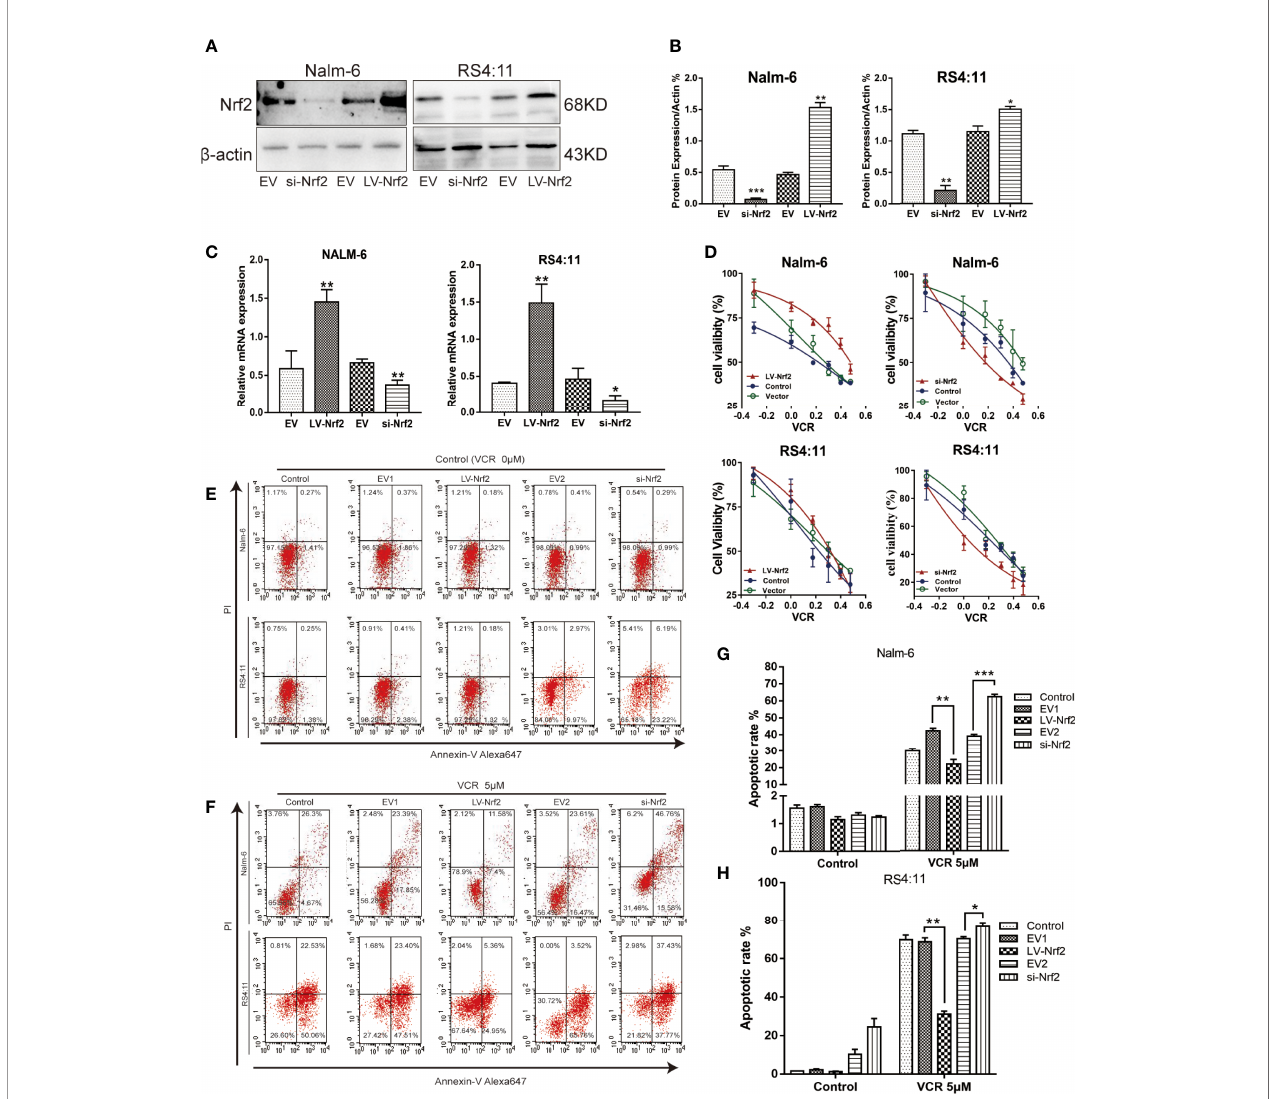
FIGURE 3 | (A) Nrf2 was overexpressed or silenced in Nalm-6 and RS4:11 cell lines determined by western blot analyses. (B) The relative grey values were shown in the histogram. (C) Nrf2 was overexpressed or silenced in Nalm-6 and RS4:11 cell lines determined by qRT-PCR analyses. (D) Dose-response curves of VCR (0, 0.05, 0.1, 0.25, 0.5, 1 and 2 m M) of LV-Nrf2 and si-Nrf2 in Nalm-6, RS4:11. CCK-8 assay after 24 h of drug exposure determined Cell viability. Data are expressed as mean ± SEM of at least three independent experiments. (E, F) The percentage of apoptotic cells was demonstrated by fl ow cytometry in both cell lines following the LV-Nrf2 and si-Nrf2 after 24h. (G, H) The percentage of apoptotic cells was demonstrated by fl ow cytometry in both cell lines following the LV-Nrf2 and si-Nrf2 after being treated with VCR (5 m M) for 24h. *P < 0.05, **P < 0.01, ***P <